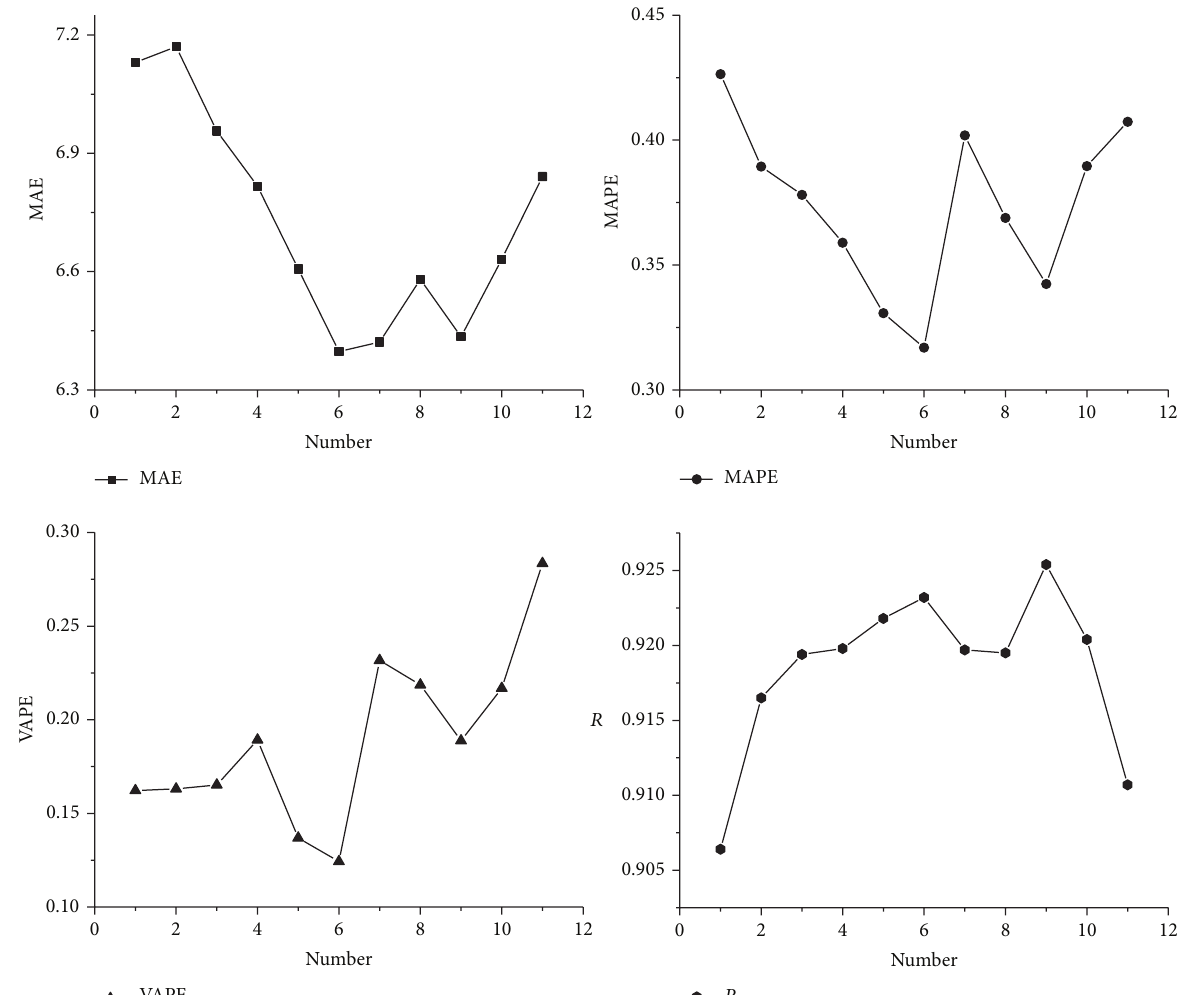
Figure 4: Trends of performance criteria of WNNMs with different number of hidden neurons.